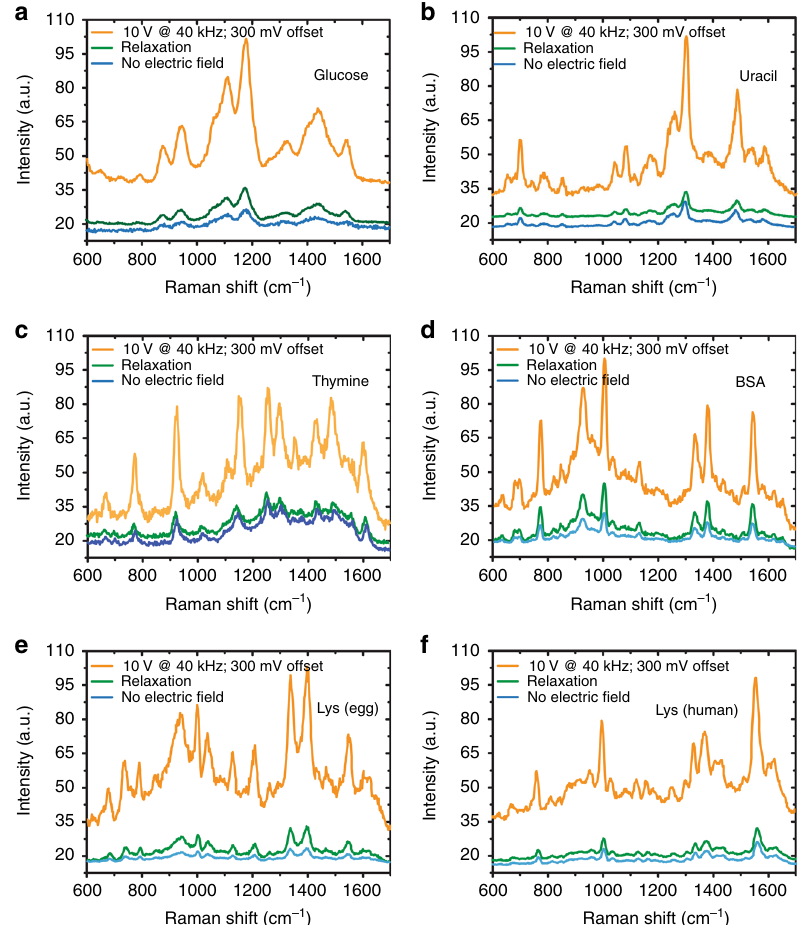
Fig. 7 SERS sensing of biomolecules on the template using an externally applied electric fi eld. SERS measurements of ( a ) glucose, ( b , c ) DNA based molecules uracil and thymine, ( d ) BSA, ( e ) Lys-egg and ( f ) Lys-human, demonstrating fi eld-enhanced sensing using the FF-PNT/Ag NP